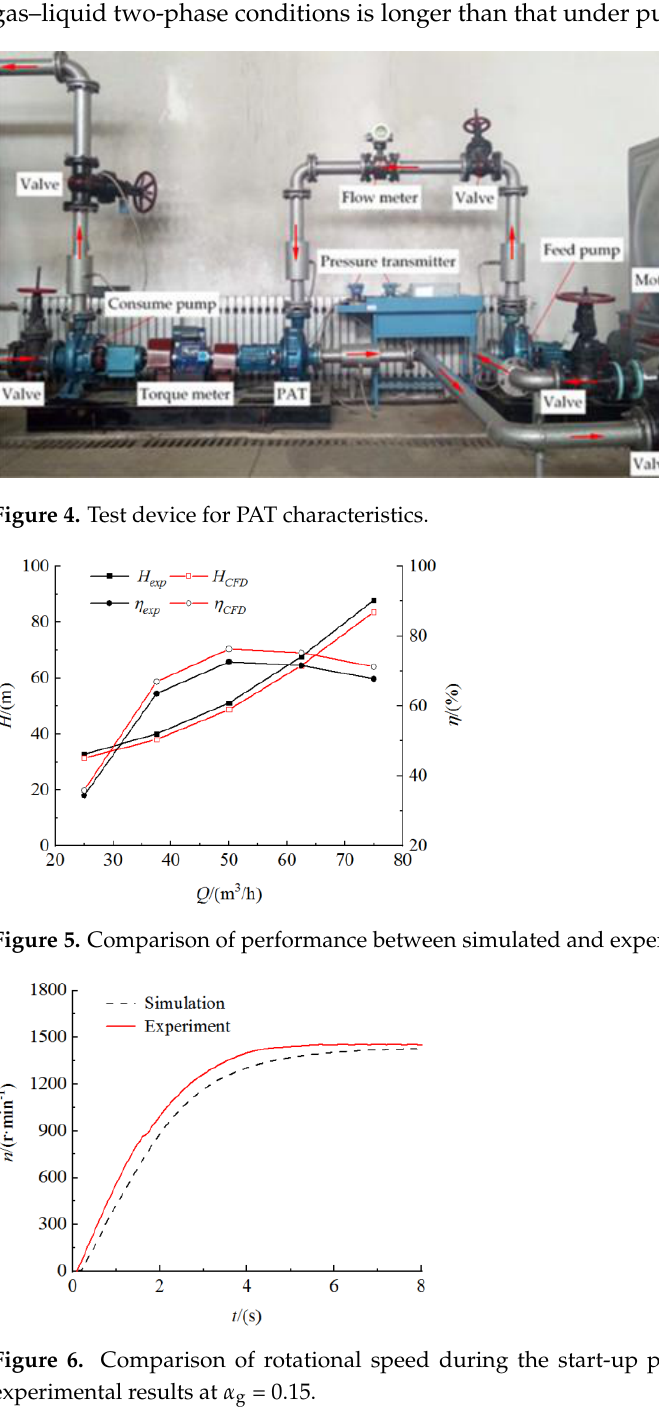
( d ) Figure 7. Pressure distribution of axial vertical plane at α g = 0.15. ( a ) t = 1 s; ( b ) t = 2 s; ( c ) t = 3 s; ( d ) t = 4 s. Figure 8 shows the velocity streamline distribution of the axial vertical surface in the flow field during the start-up process. From the diagram, it is observed that large-scale high-intensity vortices are formed in the impeller flow channel at t = 1 s. At t = 2 s, with